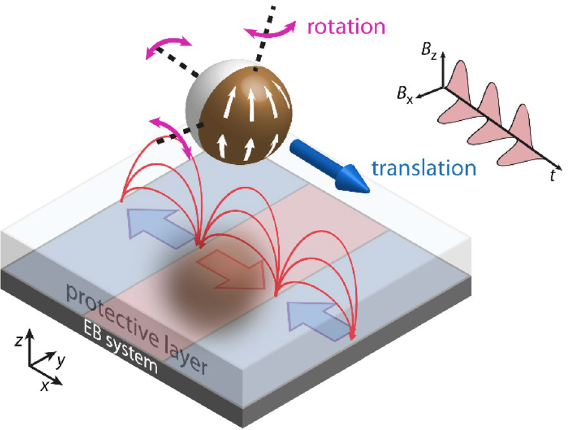
Figure 1. Sketch of a magnetic Janus particle (MJP), with a cap (brown) consisting of an in-plane exchange- biased layer system, interacting with an artificial magnetic stray field landscape on top of a